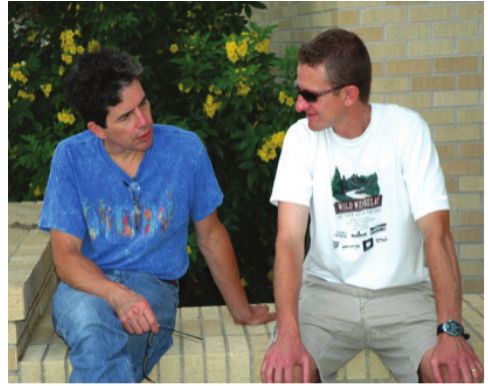
Figure 7. Richard Irish (Landsat staff, ret.) and Trent Morrell (Laramie County Community College) during a break.